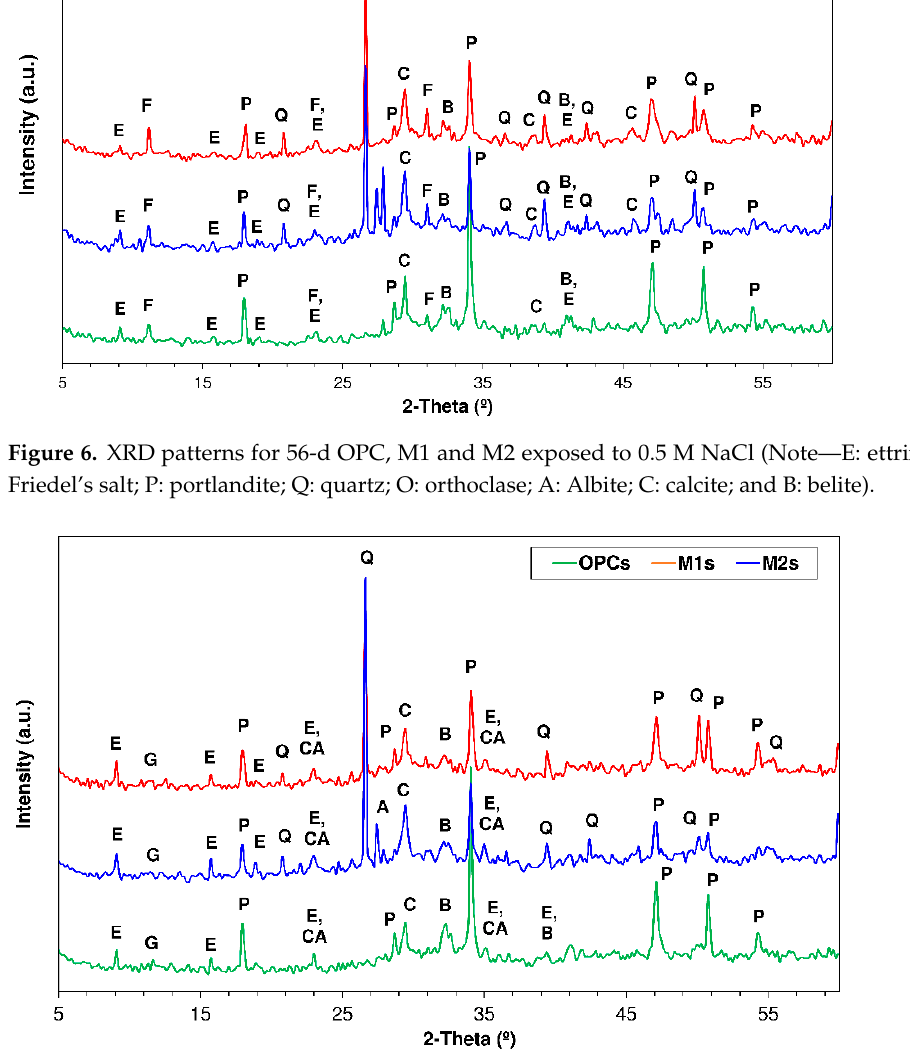
Figure 8. Calcium silicate hydrates (C-S-H gels) in 56-d water-soaked pastes: ( a ) OPC (×6000); ( b ) M1 (×6000); ( c ) M2 (×10,000). Magnesium in the form of brucite predominated in the surface layer observed to form in all the 56-d pastes exposed to seawater (Figure 9a–c), corroborating the XRD findings. Brucite, the result of the reaction between portlandite and the MgCl 2 in seawater, was present on specimen surfaces only. The layer was thicker in the OPC (e = 107.1 µm) than